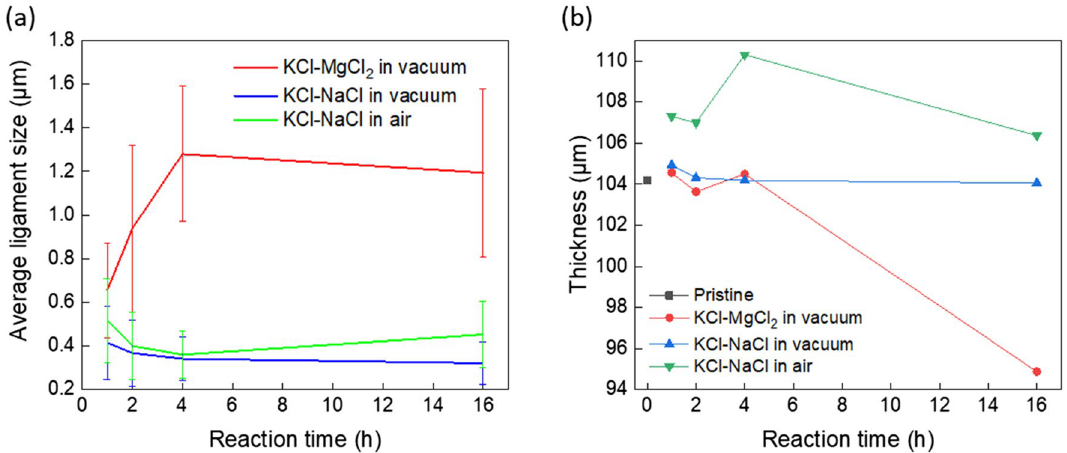
Figure 5. ( a ) Average ligament width in Ni–20Cr foils after corrosion in different molten salt conditions as a function of reaction time at 700 °C. The values for standard deviation of the measurements are also labeled as error bars. ( b ) Thickness of Ni–20Cr foils versus reaction time after corrosion in different salt conditions as a function of reaction time at 700 °C.